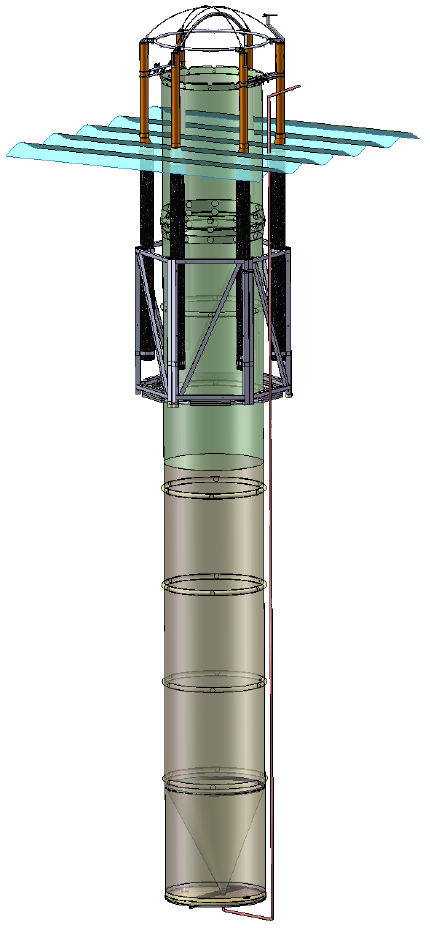
Fig. 2. Sketch of floatation frame with unfolded TPU enclosure bag; different colouring of the light-transparent bag indicates difference in TPU foil thickness: green, 1mm; brown, 0.5mm. The blue rip- pled plane represents the water line. At the bottom of the bag above the bottom plate the funnel-shaped sediment trap is indicated. The red line extending from the tip of the sediment trap to the water surface represents the tube used for sampling of sedimented matter.